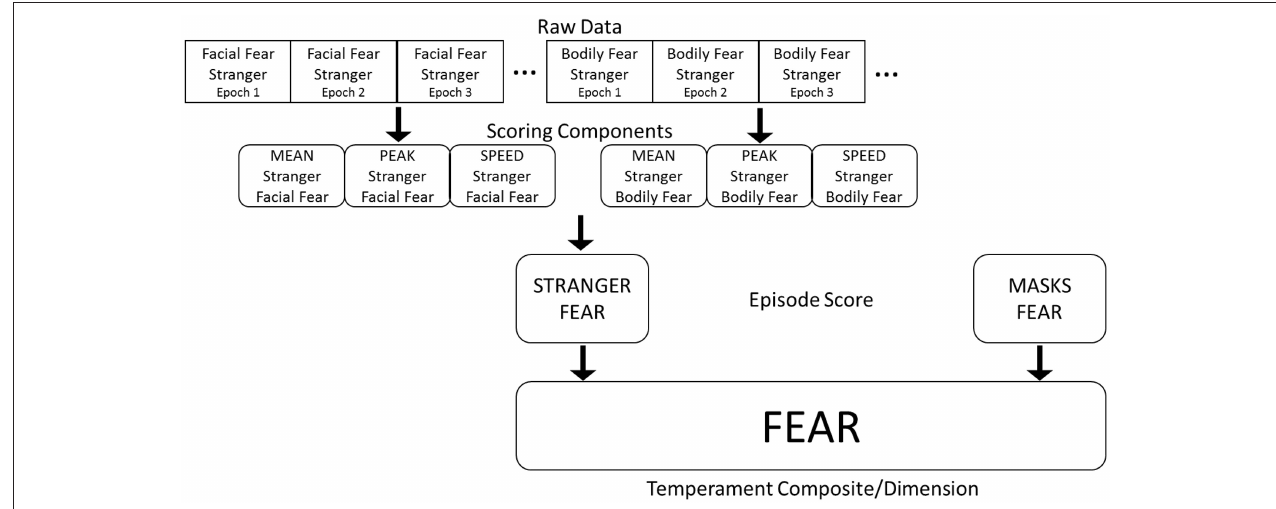
FIGURE 1 | Data reduction to derive temperament composites from Lab-TAB raw